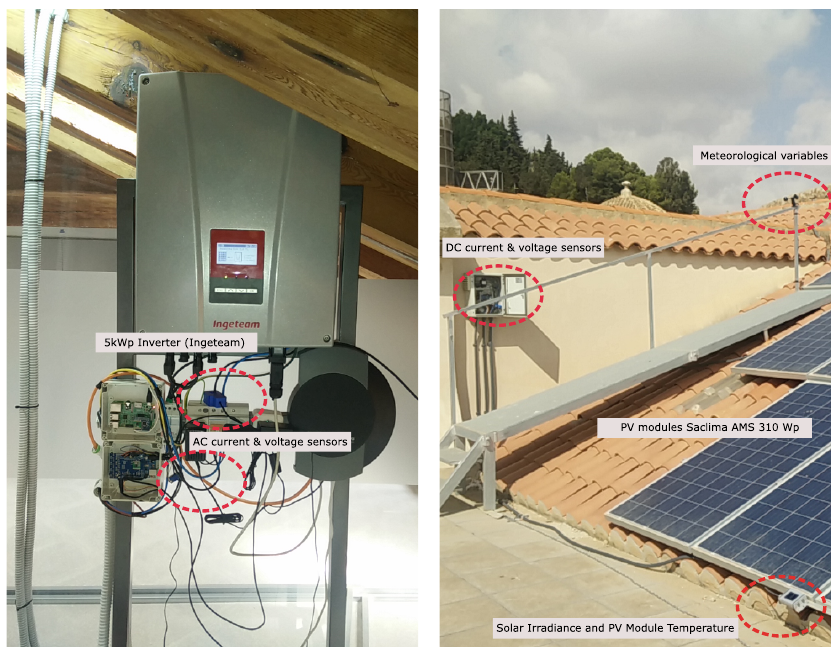
Figure 9. End nodes of 5 kWp PV installation monitoring.